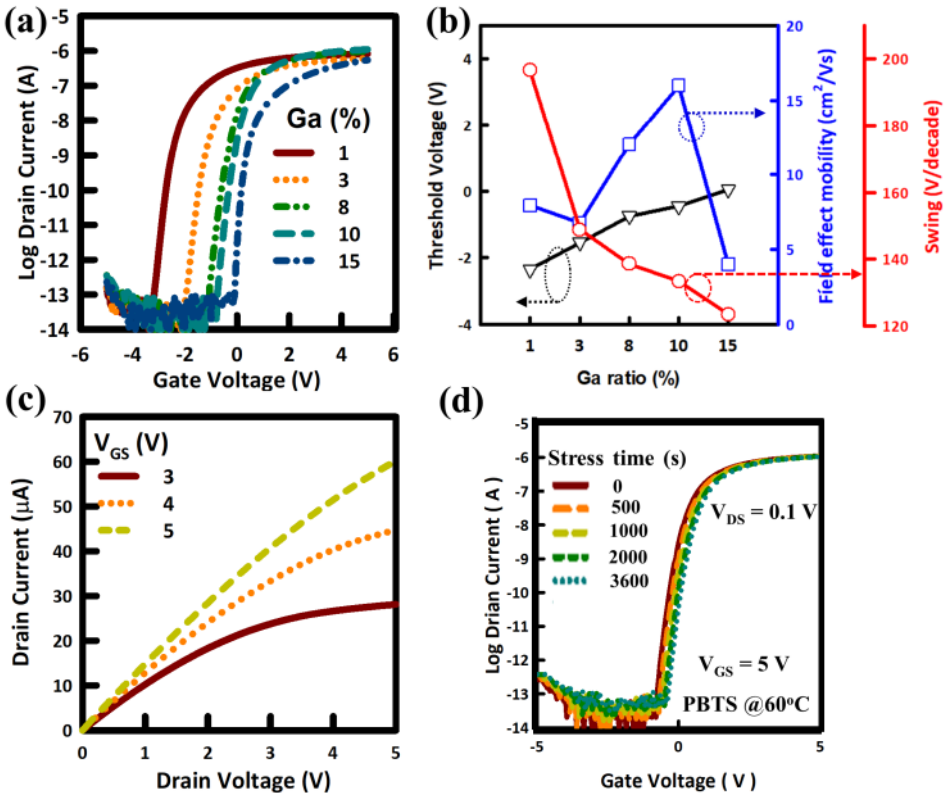
Figure 5. ( a ) Comparison of the transfer curves for IGTO TFTs, where Ga ratio varied from 1 to 15%. ( b ) Summary of the electrical parameters (V TH , µ FE , and SS) of IGTO TFTs with different Ga ratios. ( c ) Output curves of the 10% Ga doped IGTO TFTs. ( d ) The transfer curves under PBTS of the 10% Ga doped IGTO TFTs at a V DS = 0.1 V for 1 h at 60 ◦